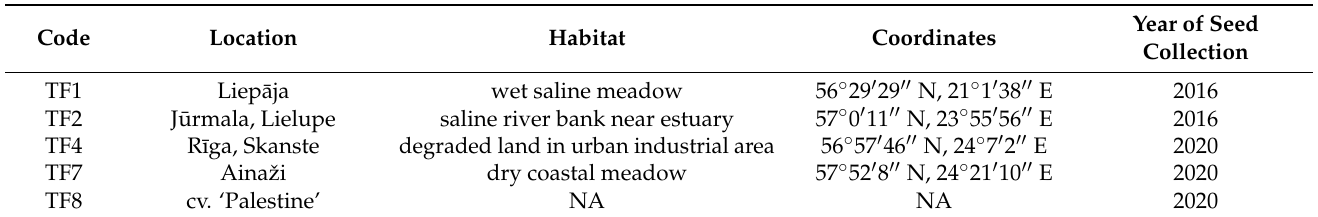
Table 5. Accessions of Trifolium fragiferum from different locations in Latvia used in the present study.